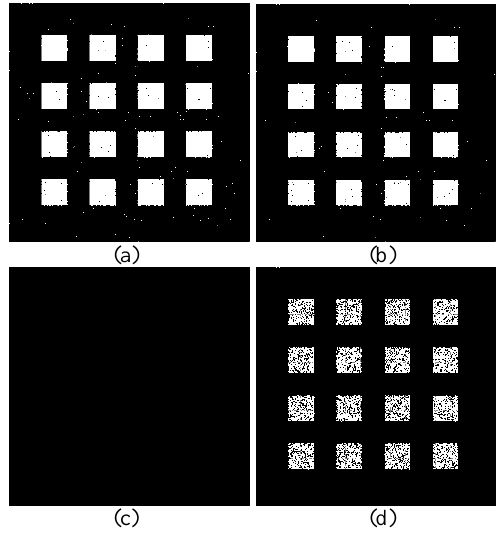
Fig. 7. Result of square: (a) Good square (ITT2); (b) Good square (ITC); (c) Bad square (ITT2); (d) Bad square